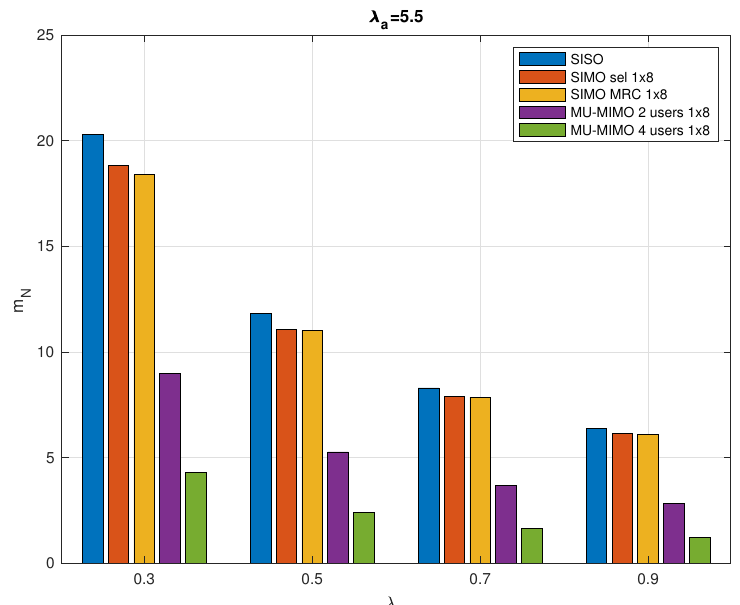
Figure 5. Mean number of required Radio Resources (RRs) in a typical cell considering λ b ranges from 0.3 to 0.9 nodes/km 2 with λ a = 5.5 nodes/km 2 , τ max = 1 ms.